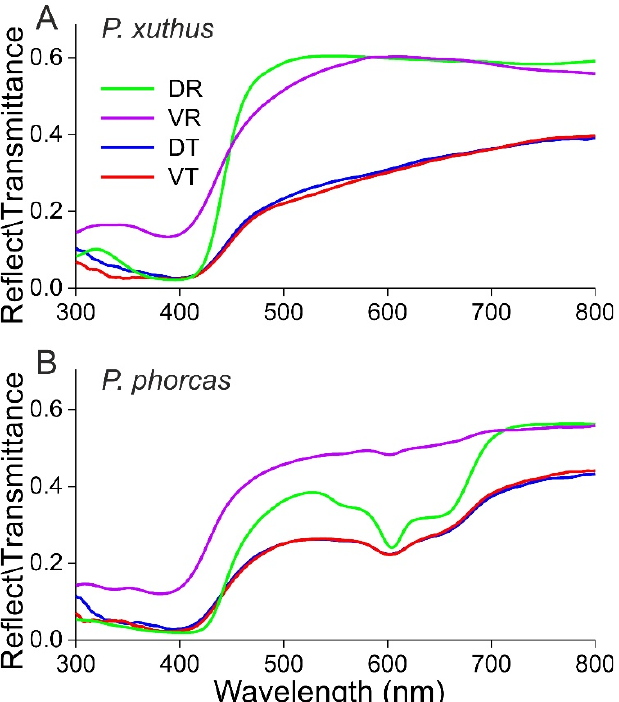
Figure 2. Reflectance and transmittance spectra of butterfly wings: ( A ) Papilio xuthus Linnaeus, 1758; ( B ) Papilio phorcas Cramer, 1775. DR—dorsal reflection; VR—ventral reflection; DT—dorsal transmission; VT—ventral transmission.